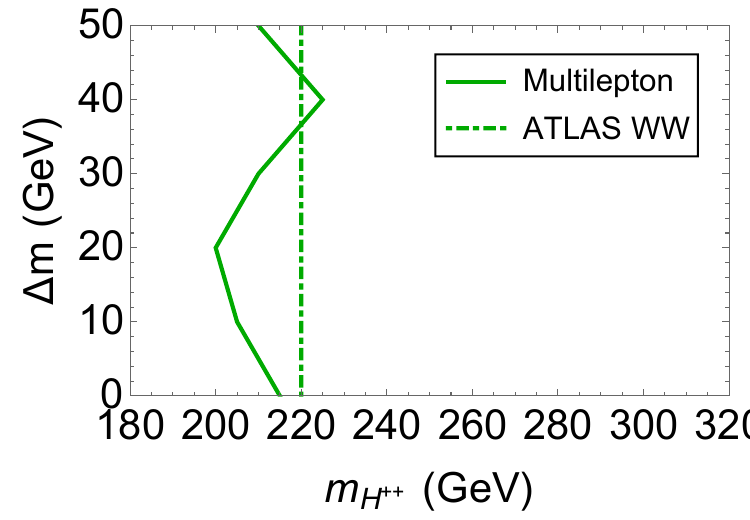
Figure 6 . The comparison between the ATLAS same sign diboson bounds [25] and the bounds from recasting the CMS multilepton analysis [42] for v respective line is